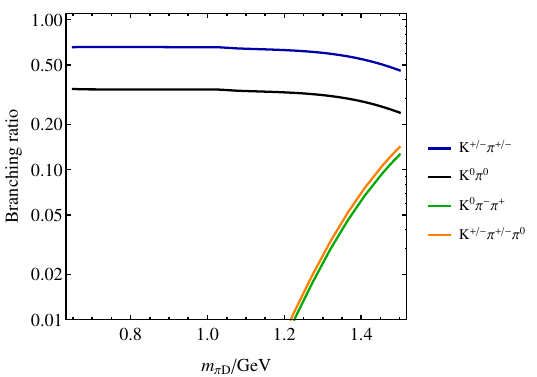
Figure 11. Plots showing the width to hadrons calculated in both the chiral and partonic picture, for (cid:20) = 1 3 3 , f D = m (cid:25) D . Plots are shown for each pion that can decay hadronically with these (cid:2) parameter choices.